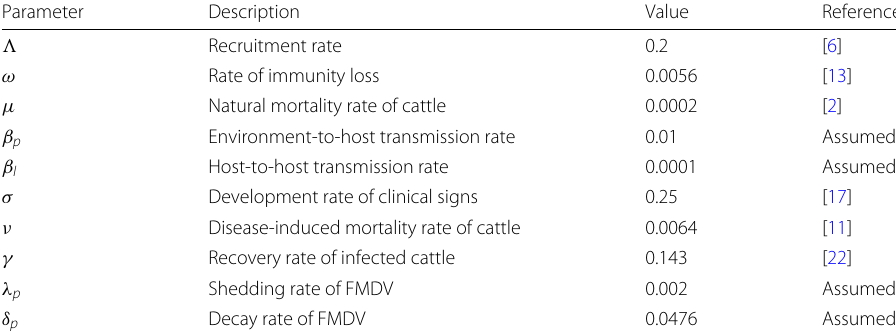
Table 1 Model parameters and their values Parameter